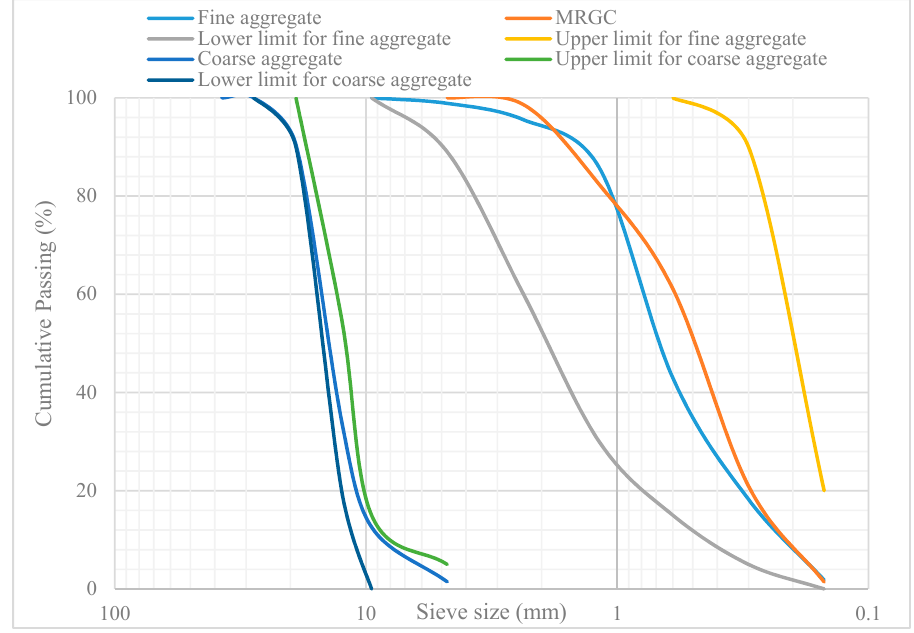
Figure 2. Grain size distribution of MRGC, fine aggregate, coarse aggregate, and standard limits.